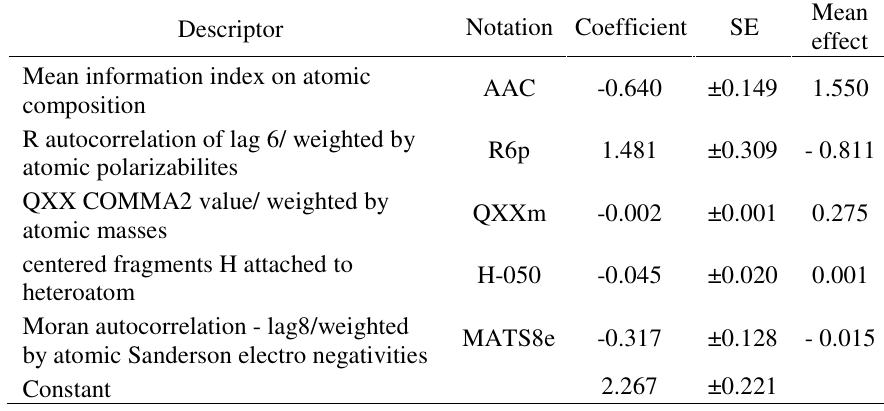
Table 2. Specification of GA-MLR